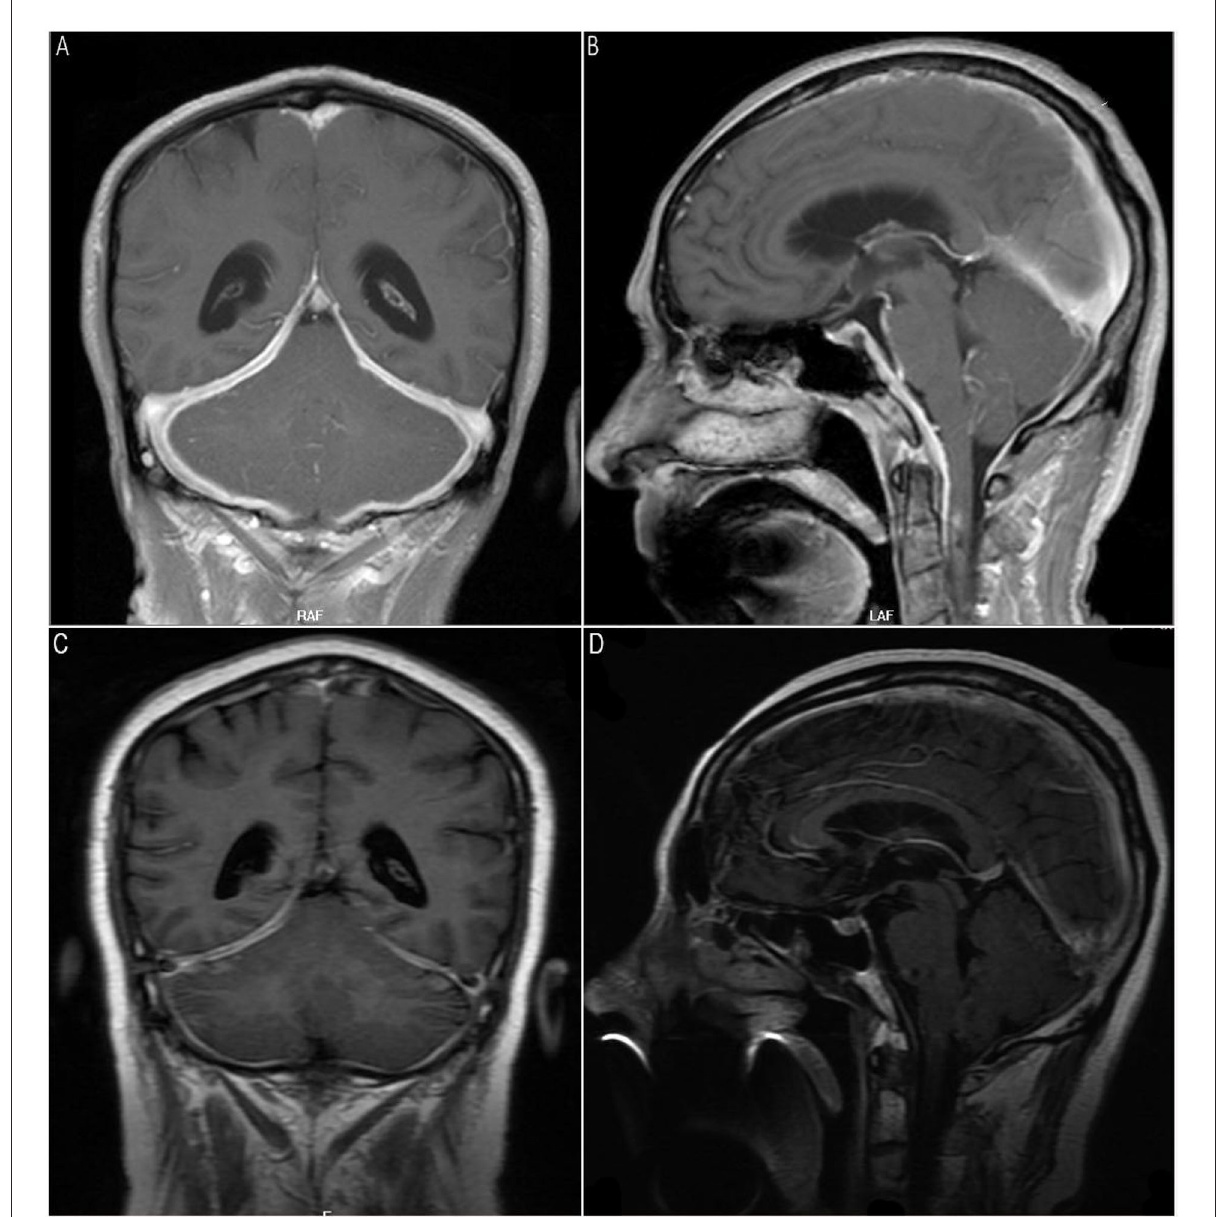
FIGURE1 Magnetic resonance imaging (MRI) scan of the brain on admission. T1-weighted gadolinium-enhanced brain MRI revealed enhancement and thickening of dura mater predominantly in the posterior fossa (A,B) . Marked reduction of dura thickening and enhancement was evident at the 6-month follow-up (C,D)